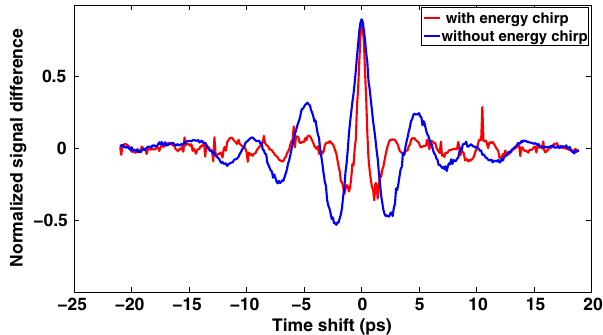
FIG. 14. Autocorrelation measurement with Martin-Puplett in- terferometer with and without energy chirp.